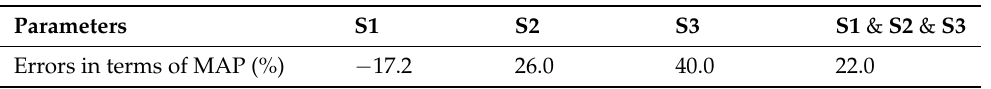
Table 5. Comparison of results obtained by inversion of sensor signals at different positions under the physical experiment. Parameters S1 Errors in terms of MAP